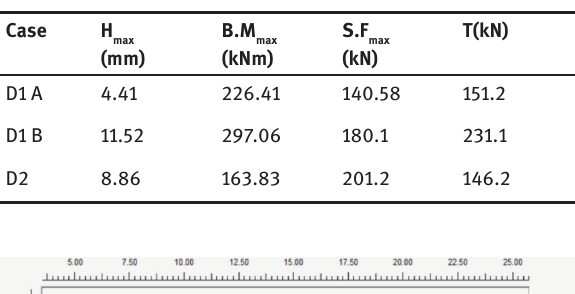
Table 5: Results of analysis with EC7.